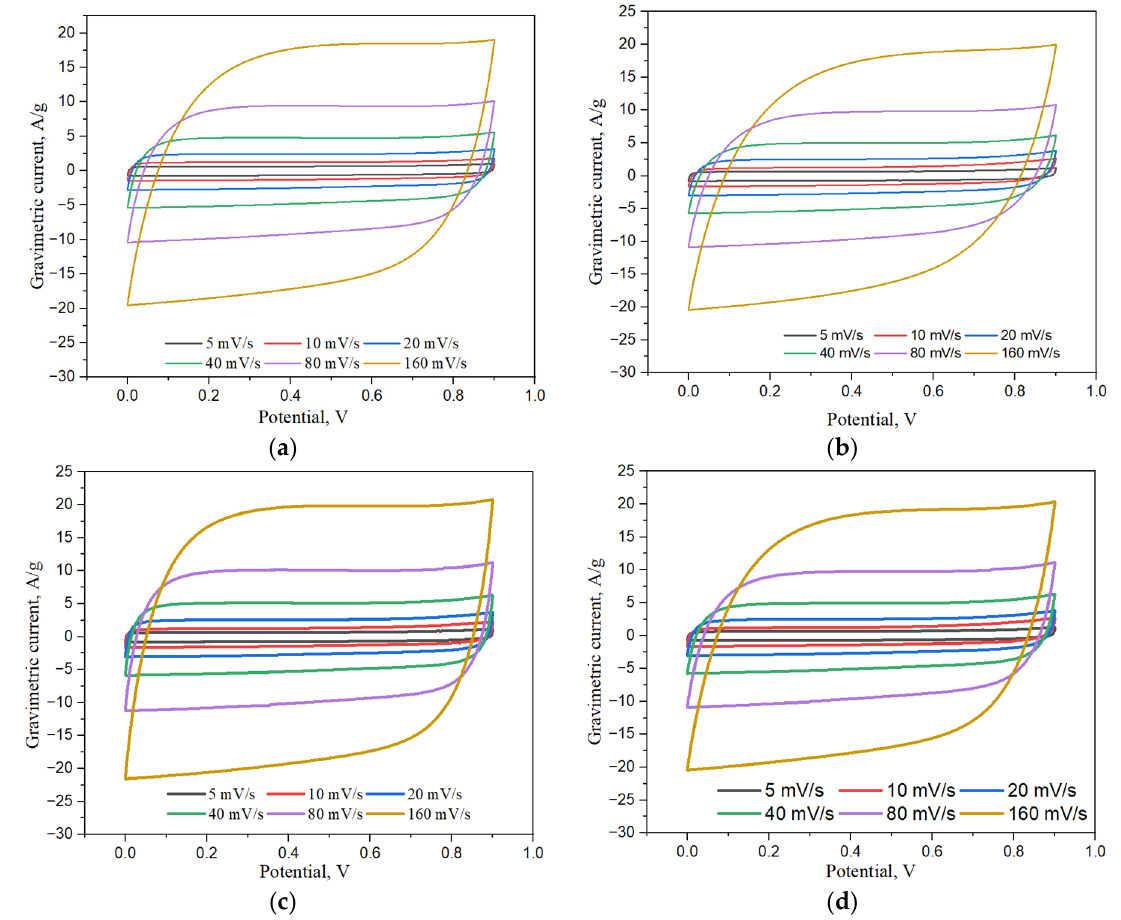
Figure 3. CV curves at different scan rates (5–160 mV/s) for ( a ) WS-dAC; ( b ) WS-dAC/NiO-0.001; ( c )